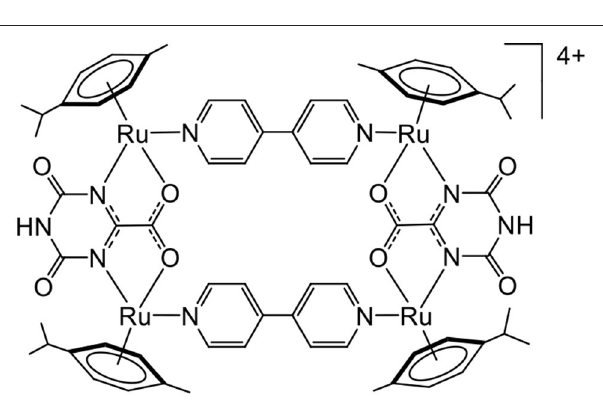
FIGURE 3 | Arene ruthenium metalla-rectangle interacting with DNA (Linares et al., 2009).